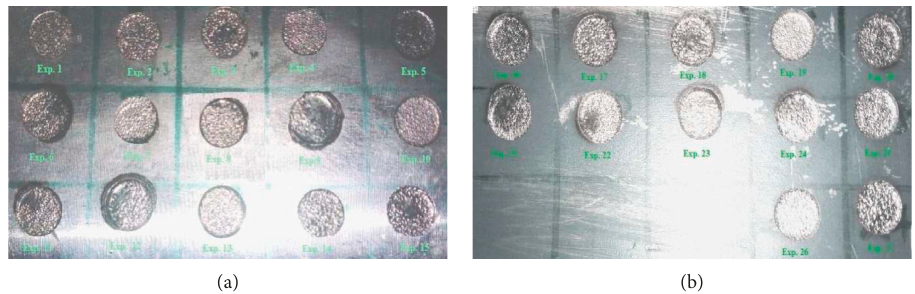
Figure 6: Images of EDMed Work piece after completion of 27